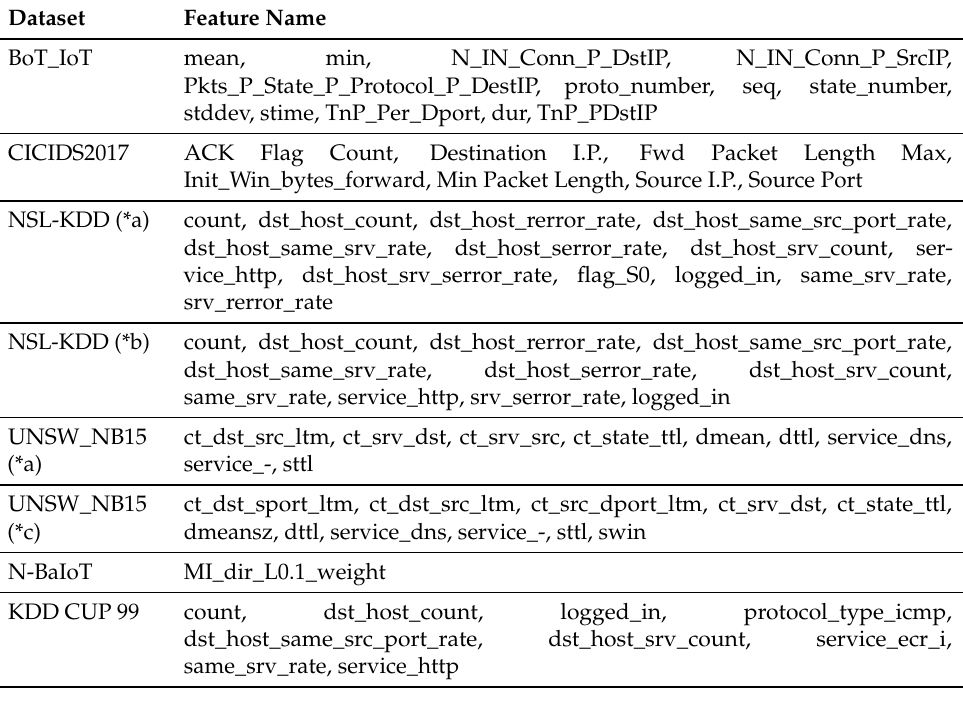
Table 4. Top features identified by all classifiers.